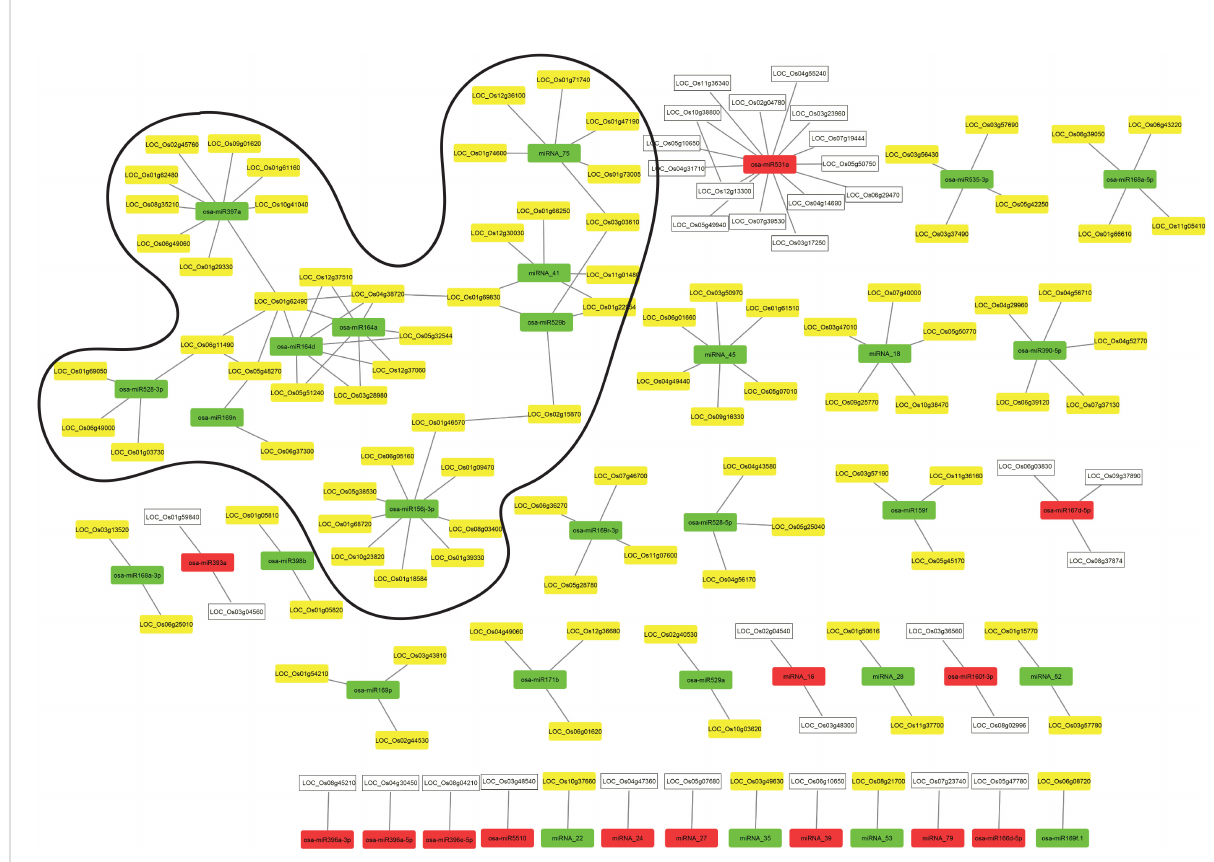
FIGURE 8 Integration of regulatory miRNA-mRNA network with PPI network during coleoptile senescence in rice. Protein-protein interaction network for the predicted target genes of conserved and novel miRNAs was generated using Cytoscape visualization software. The expression of miRNAs and target genes is presented based on the RNA-seq and small RNAome data obtained for coleoptile senescence in rice, respectively. Upregulated and downregulated miRNAs are represented by red and green boxes, respectively. Upregulated and downregulated predicted target genes are represented by yellow and white boxes, respectively. The predominant hub identi fi ed in the present study is